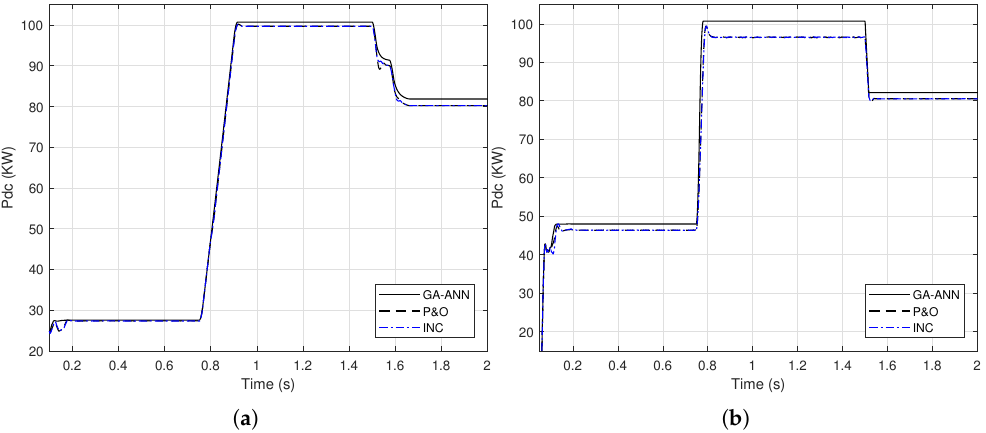
Figure 13. A comparison of the output DC power of the PV array using GA-ANN, P&O and INC for; ( a ) linear variation of G and T c ( b ) step variation of G and T c